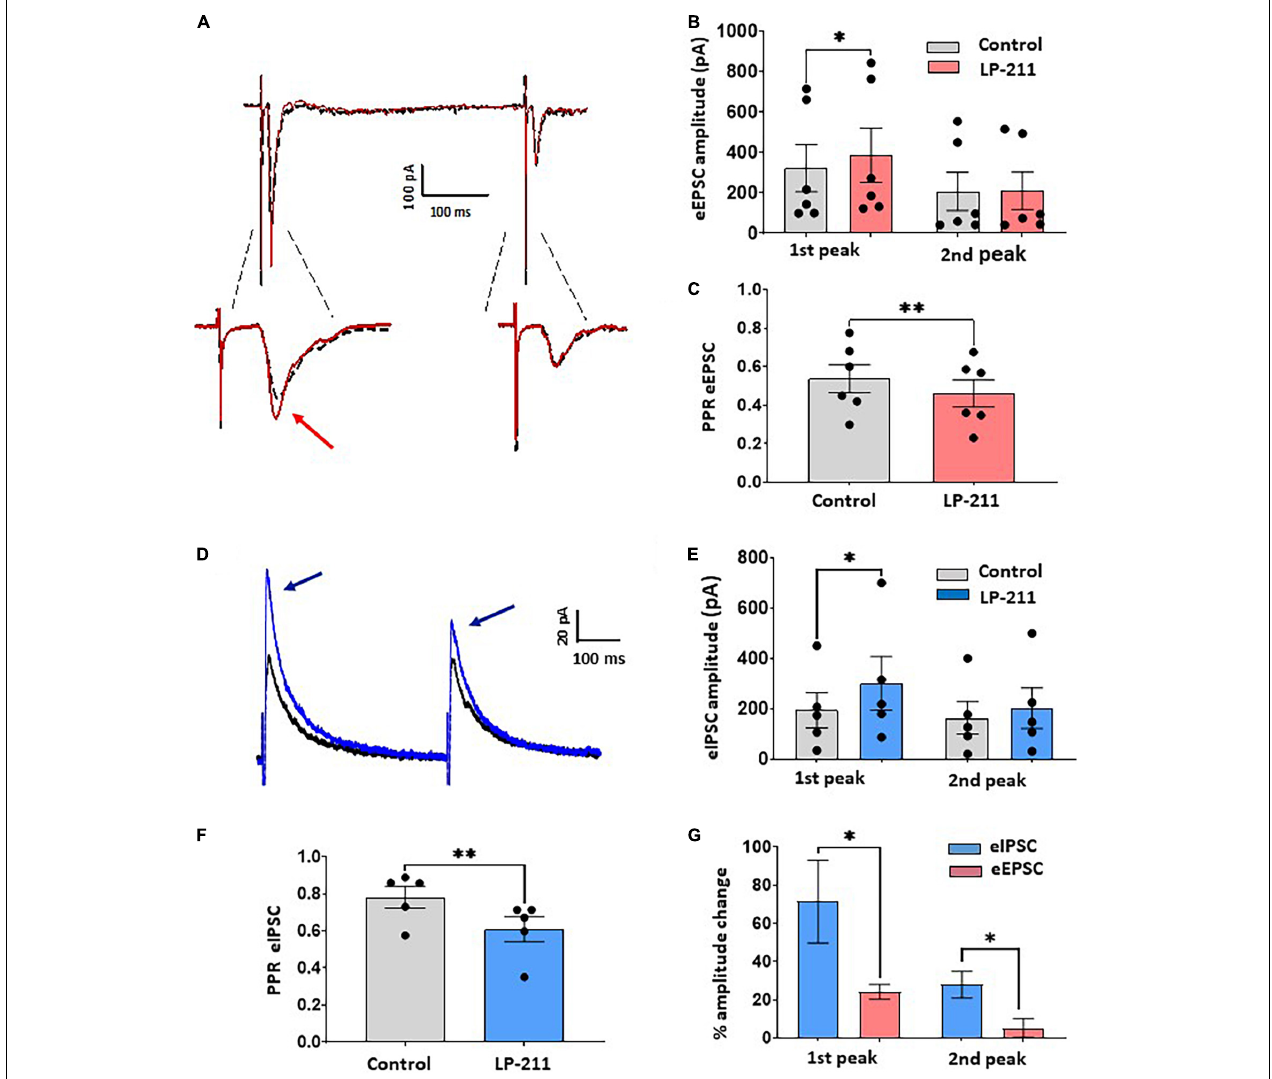
FIGURE 3 | Application of LP-211 facilitates evoked excitatory postsynaptic currents (EPSCs) and Inhibitory postsynaptic currents (IPSCs), exerting a stronger action on inhibitory transmission. (A) Example of EPSC recordings (eEPSCs), evoked by dorsal root stimulation (500 mA, 0.1 ms) and recorded at –70 mV. Two stimuli were applied at 400 ms intervals (paired pulse protocol). LP-211 (1 µ M, red trace) caused a moderate potentiation of evoked EPSCs in 5 out of 11 cells tested. (B) The first EPSC was significantly increased (Wilcoxon rank-sum test, p < 0.05, n = 6 EPSCs from 5 cells), while the second peak was not changed (Wilcoxon rank-test, p = 0.76, n = 6). (C) Paired pulse ratio (PPR = second EPSC/first EPSC) was significantly decreased by LP-211, suggesting a presynaptic action (paired t -test, p < 0.01, n = 6). (D) Recordings of IPSCs evoked by focal stimulation (paired pulse protocol) and recorded at 0 mV, in the presence of NBQX (10 µ M) and D-AP5 (50 µ M): in this example, LP-211 caused the increase of both IPSCs (blue trace). (E) The first IPSC underwent a stronger potentiation than the second peak, as observed in 5 responsive cells out of 11 (first peak, paired t -test, p < 0.05; second peak: paired t -test, p = 0.07, n = 5). (F) Paired pulse ratio was significantly decreased (paired t -test, p < 0.01, n = 5), confirming a presynaptic effect. (G) Evoked inhibitory currents were more affected by 5-HT 7 R activation compared to excitatory responses, as revealed by the higher percentage increase of both evoked IPSC peaks (Mann–Whitney test, p < 0.05, n = 5 and 6 for IPSCs and EPSCs, respectively). Asterisks reported in the graphs represent statistical significance: ∗ p < 0.05; ∗∗ p < 0.01; ∗∗∗ p <